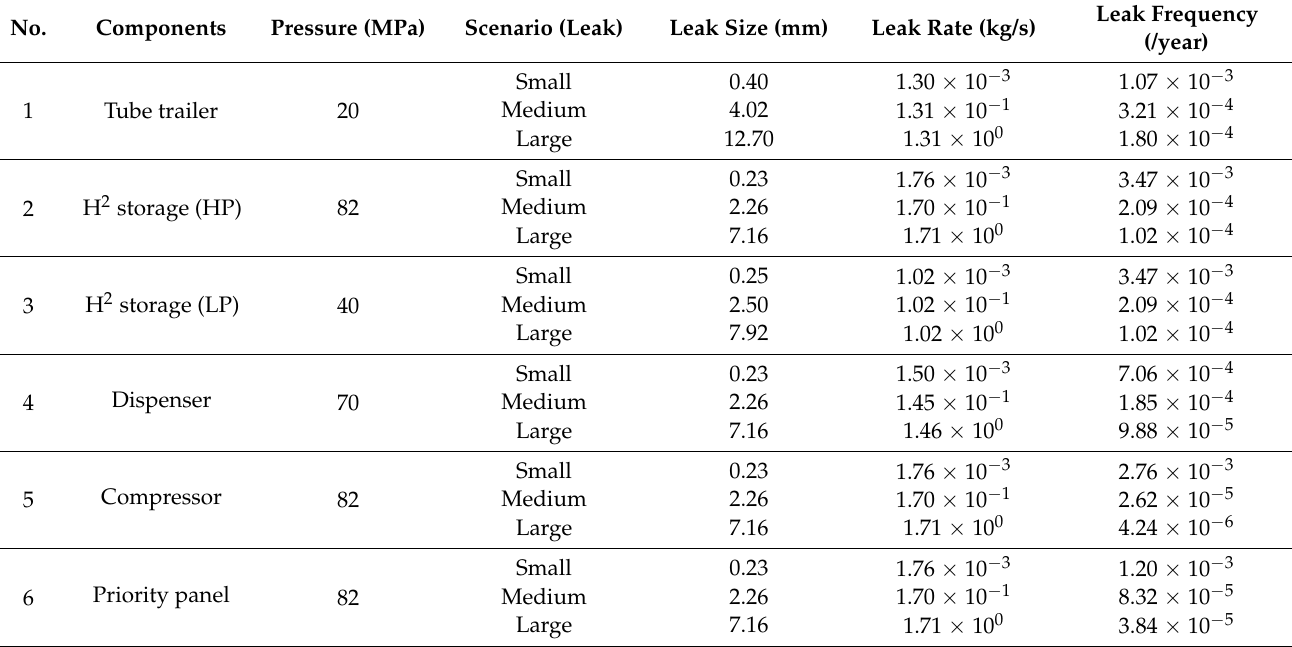
Table 3. Input values for each component for risk assessment of hydrogen refueling stations (Sandia National Laborato- ries, 2009).